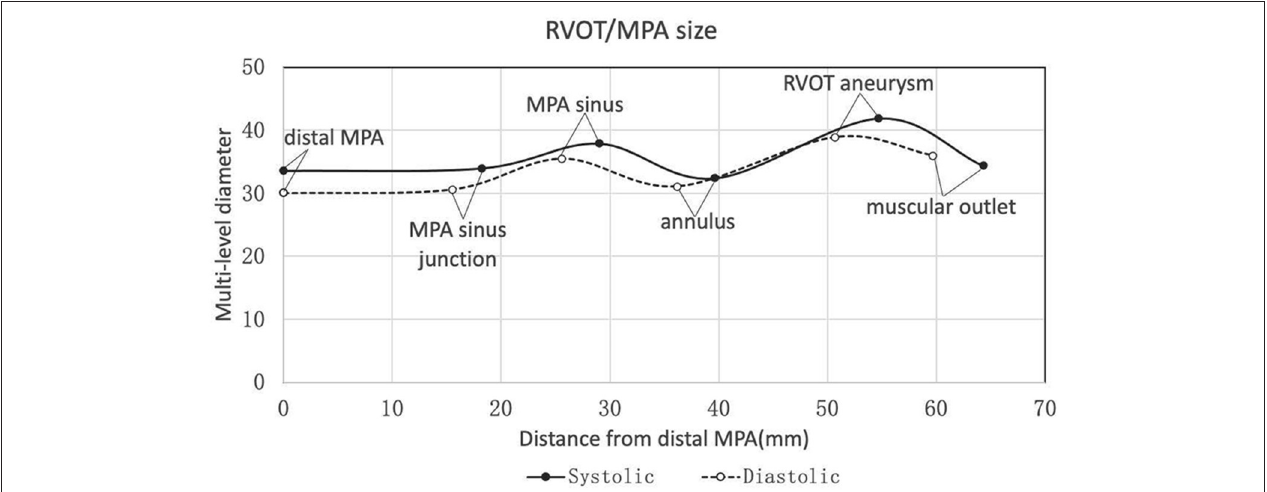
FIGURE 2 | Multi-level diameters and distances of right ventricular outflow tract/pulmonary artery measured by three-dimensional CTA reconstruction in the systole and diastole. CTA, computed tomography